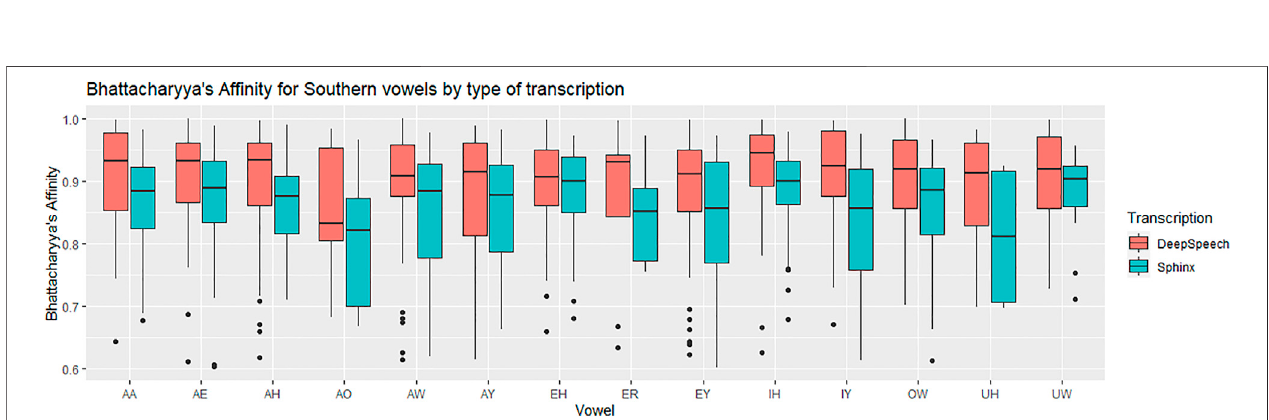
FIGURE 5 | Southern data: vowel medians for the Bhattacharyya ’ s af fi nity by type of transcription. Red: DeepSpeech versus ground truth, Green (cid:1) CMU Sphinx versus ground truth. 105 speakers and a total of 28,225 vowel tokens.